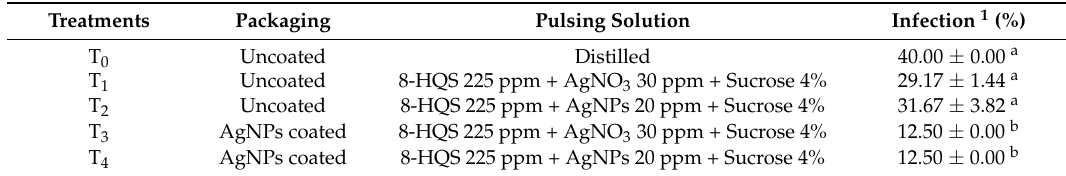
Table 5. Percentage of infected cut orchid flowers during the packaging test conducted for 7 days.